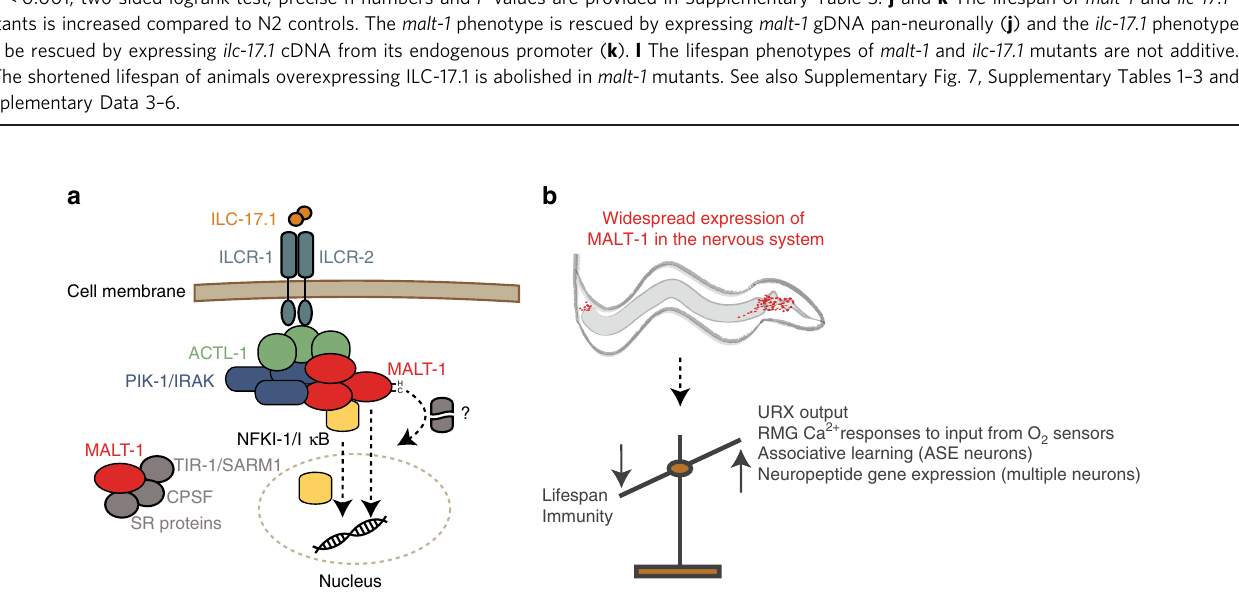
Fig. 9 Model. a Activation of nematode IL-17Rs ILCR-1 and ILCR-2 engages ACTL-1, the C. elegans ACT1-like adapter, probably via their SEFIR domains. ACTL-1 recruits the C. elegans IRAK and MALT1 homologs to form the ACT1-IRAK-MALT1 signalosome in the cytoplasm. This serves a scaffolding function to recruit I κ B ζ /NFKI-1, and modulate its actvity by an unknown mechanism. NFKI-1 probably orchestrates changes in the transcriptome of RMG and other cells. MALT1-mediated cleavage of unknown substrate(s) positively regulates NFKI-1 signaling. In parallel to this pathway, MALT-1 forms a complex of unknown function with TIR-1/SARM1, and with multiple RNA-binding proteins. b ILCR receptors and downstream signaling components including MALT-1 are expressed in many neurons. This neuronal signaling cassette alters associative learning, as well as O 2 -escape behaviors, and suppresses lifespan and